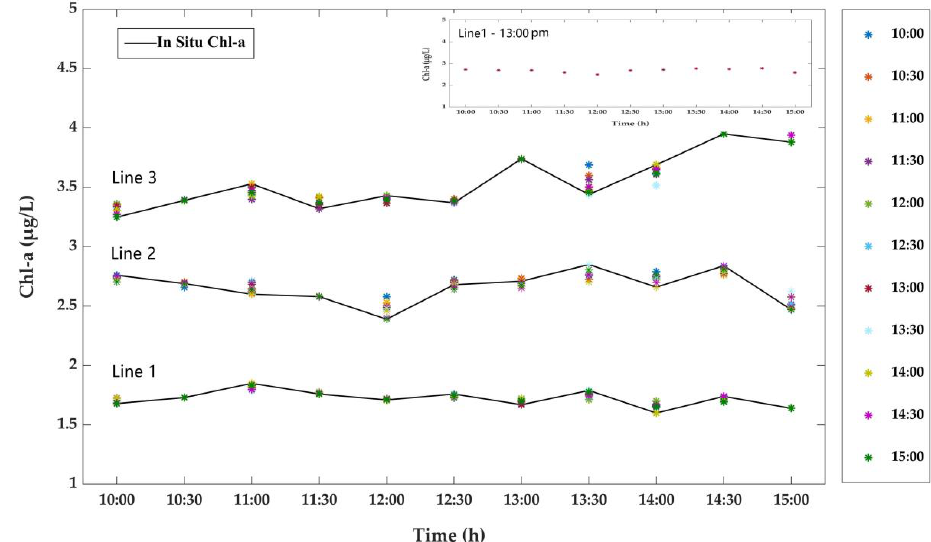
Figure 4. Prediction of Chl-a by GRNN-based multi-parameters forecasting model in sunny-day dataset. Lines 1, 2, and 3 show predicted Chl-a at different concentration ranges, respectively.